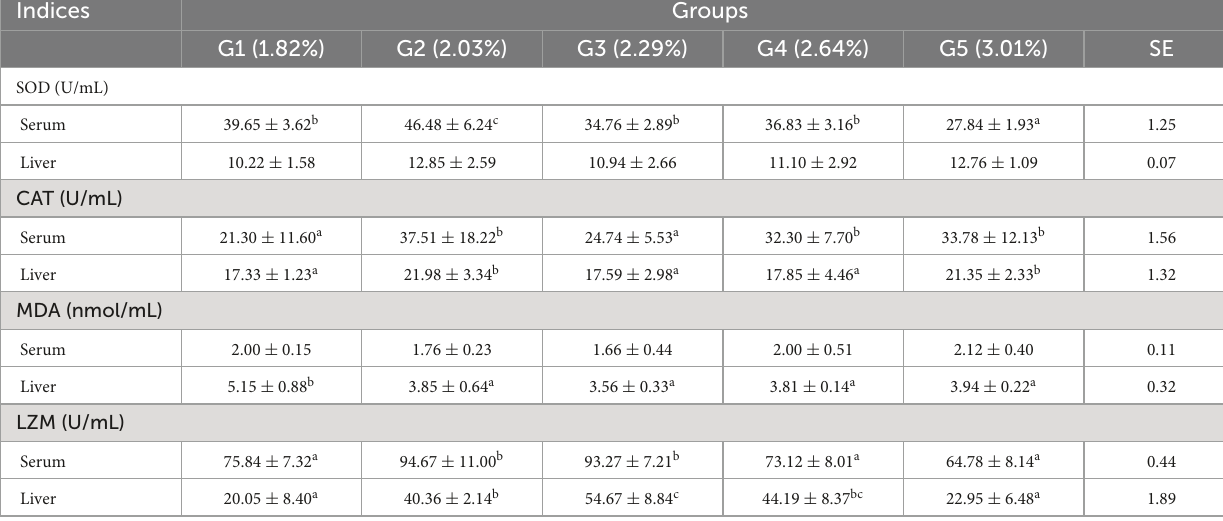
TABLE 8 Effects of dietary phenylalanine levels on the antioxidant capacity of triploid O. mykiss . Indices Groups